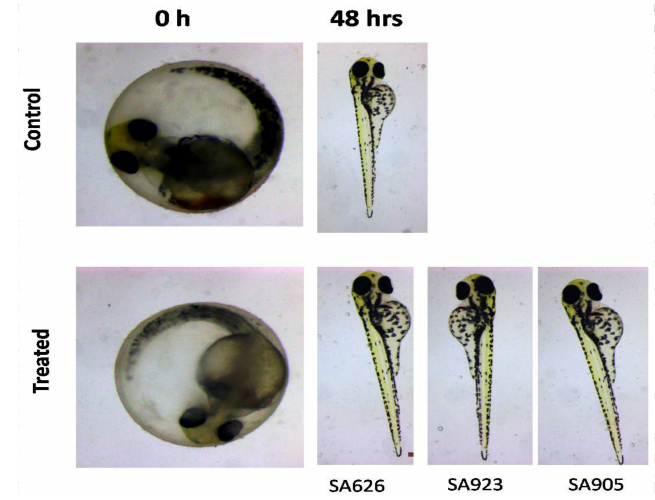
Figure 6. Effects of peptides on zebrafish embryos. Embryonic development is the most important stage for organogenesis in zebrafish. Thus, from the present study, it is determined that peptides from S. amaranthoides do not demonstrate any toxic effect on embryos. Peptides promote postfertilization, organogenesis, and hatching of the larvae without any structural abnormalities. The mass spectrum also revealed different sugar-based molecules (SA1029.3, SA1013.4, SA887, SA757.2, and SA741.2), such as multiple hexose and fucose molecules (Figure 7).